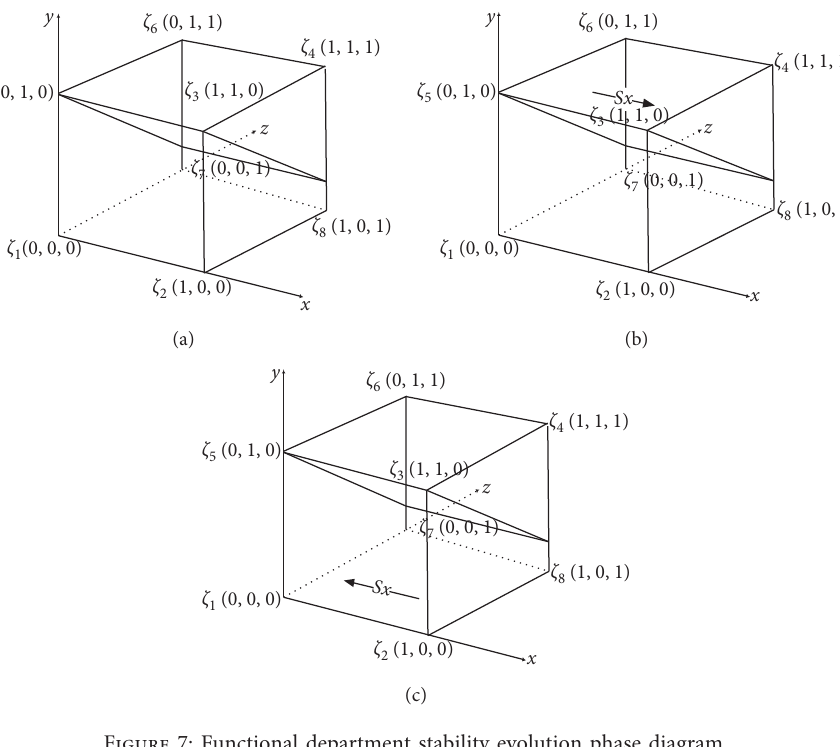
Figure 7: Functional department stability evolution phase diagram.